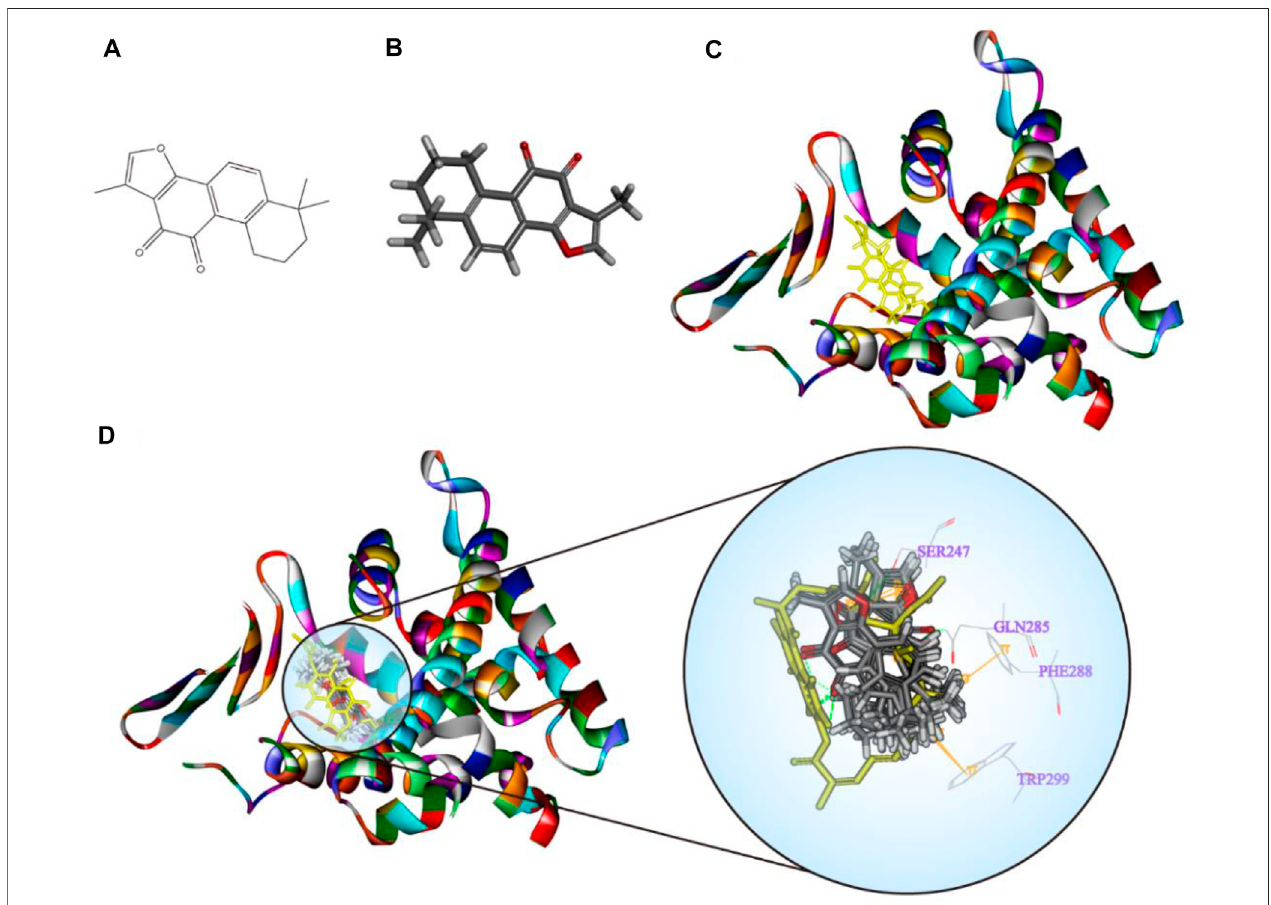
FIGURE7| Diagramsoftheinteraction ofTanIIAwiththecrystalstructureofPXR(1SKX). (A,B) Chemicaland3Dstructure ofTanIIA; (C) the3Dcrystalstructureof human PXR and ligand-binding domain with an endogenous ligand (yellow) (PDB ID: 1SKX); (D) twenty poses of TanIIA docked into the endogenous ligand ’ s (yellow) activesiteof1SKX;thebindingmodelofTanIIAinPXR:atleastfourresiduesinvolvedintheinteractionsintwentyrandomposes,H-bondswithSER 247 ,GLN 285 ,and π – π interaction with PHE 288 and TRP 299